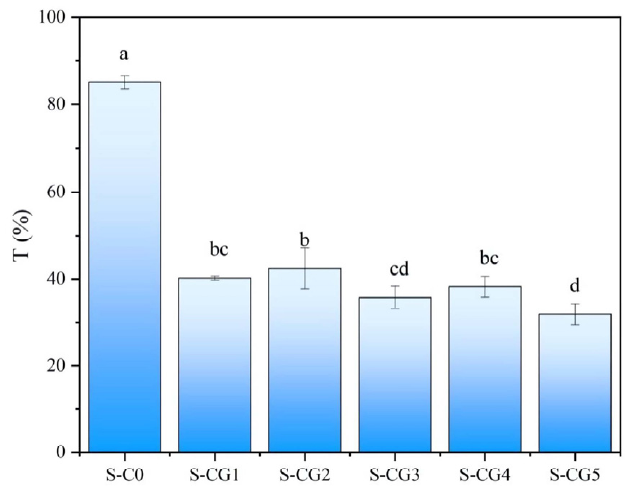
Figure 6. The transmittance of composite films. Results are expressed as average, and different letters (a–d) indicate significant differences ( p < 0.05).